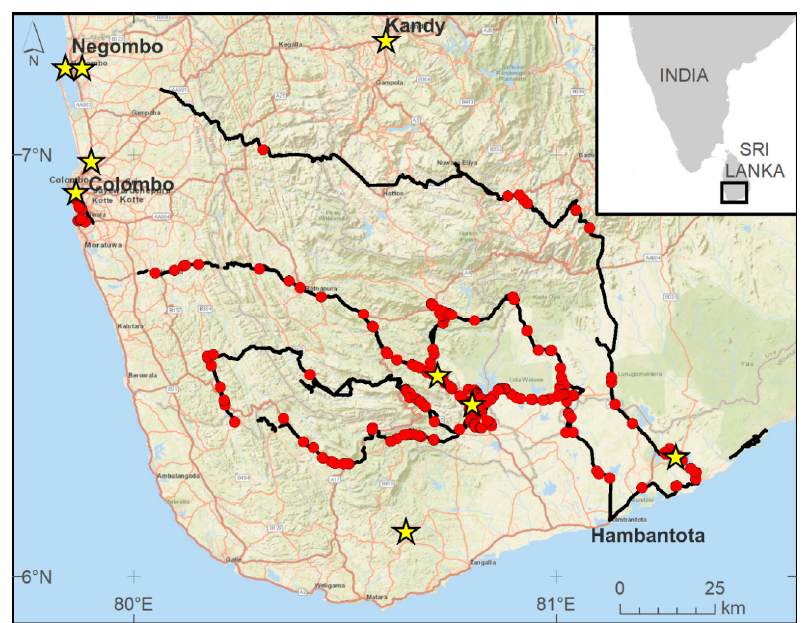
Figure 2. Study area in the Southern half of Sri Lanka. Black lines are the roads driven to locate distribution power lines and electrocuted Indian flying foxes. Yellow stars show the colonies known of this species, and red circles the location of electrocuted individuals.